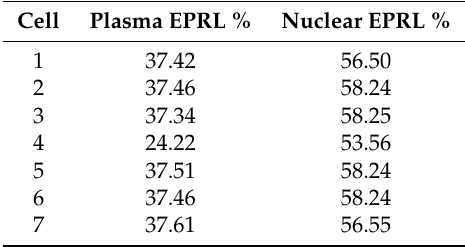
Figure 7. Packed System—Nuclear membranes pore density versus the polar angle at time instant t = 20 ns for ( a ) cell 1, ( b ) cell 2, ( c ) cell 3, ( d ) cell 4, ( e ) cell 5, ( f ) cell 6, ( g ) cell 7. Pulse amplitude and duration equal to 100 kV/cm and 10 ns, respectively. Table 3. Electroporation Relative Length of the Packed